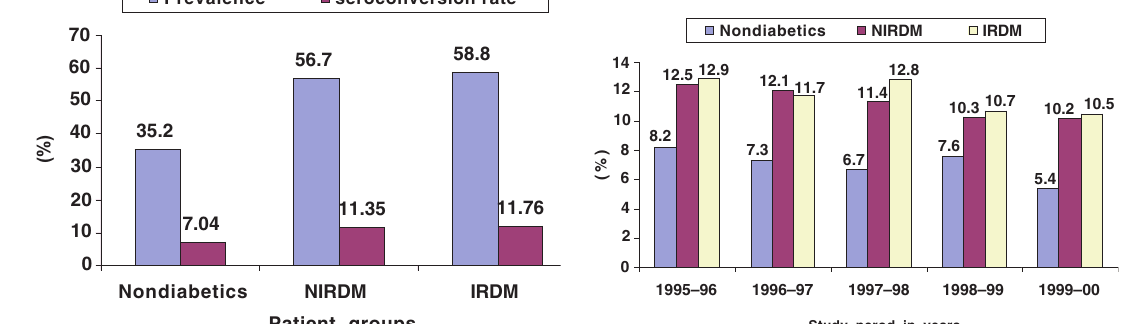
Annual HCV seroconversion rates in non-diabetic and Type-2 diabetic (NIRDM & IRDM) patient groups on long-term HD. NIRDM – non insulin requiring diabetes mellitus, IRDM – insulin requiring diabetes